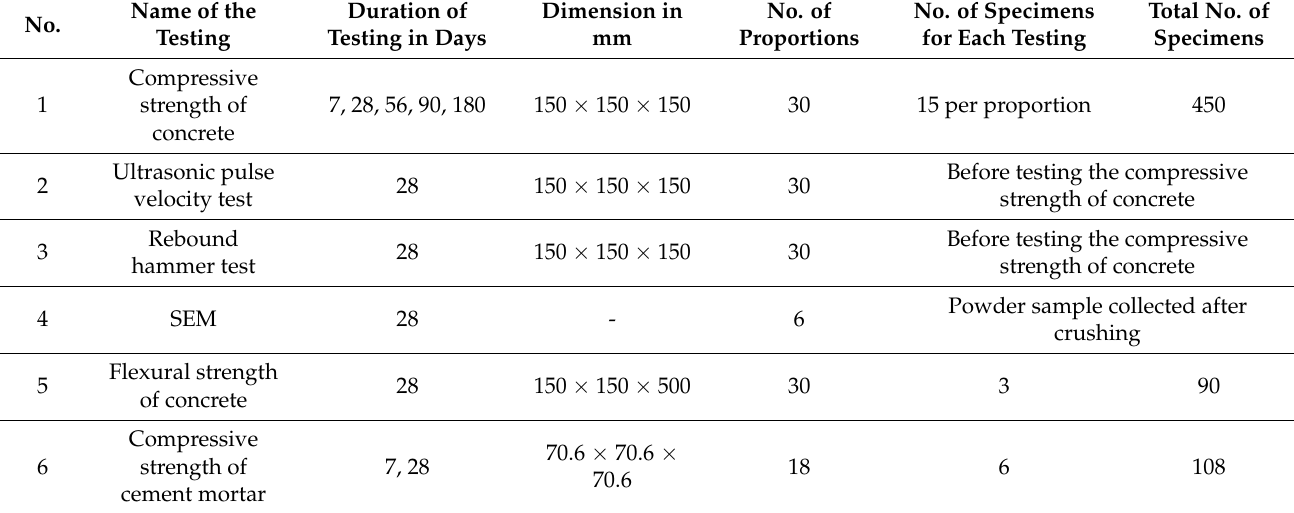
Table 4. Tests conducted, test duration, and number of